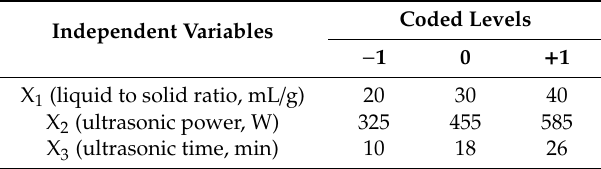
Table 2. Independent variables and their levels used for Box–Behnken design (BBD).